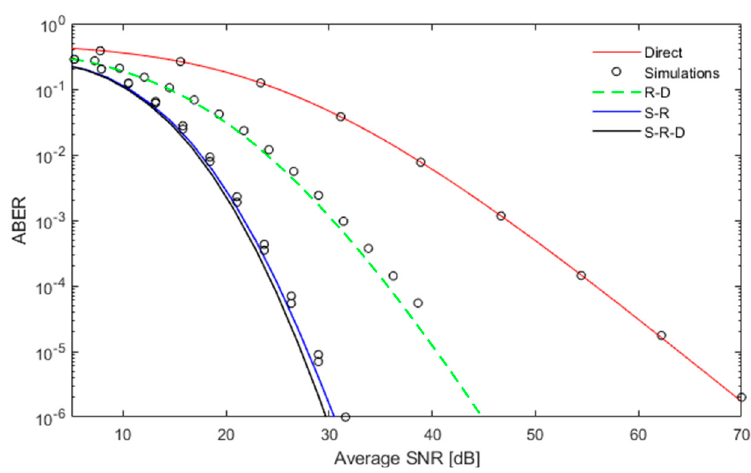
Figure 13. ABER vs. SNR of FSO over the G ‐ G channel for strong turbulence with distance 600–400 m, the number of relays = 3 and w z = 2 m.